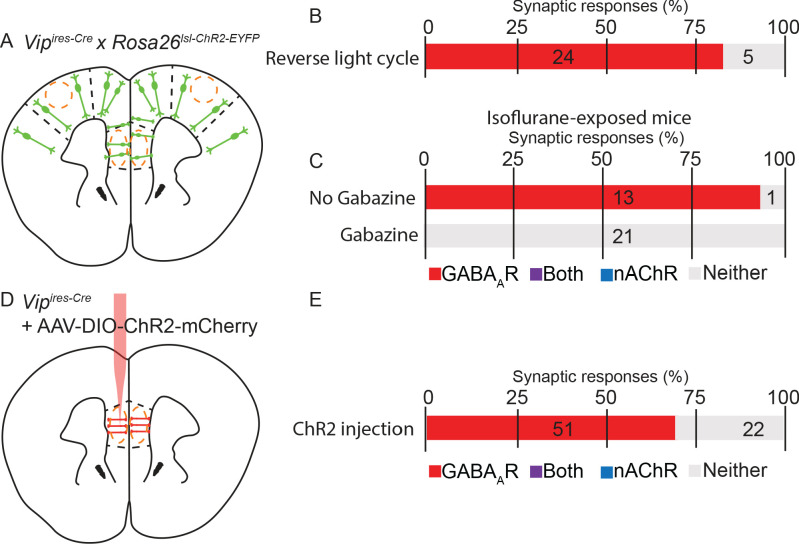
ACh-mediated synaptic connectivity is not effected by circadian cycle or viral injection.(A) Experimental design: Acute slices from Vipires-Cre x Rosa26lsl-ChR2-EYFP mice were prepared and whole cell voltage clamp recordings obtained from layer 1 interneurons. (B) Summary quantification of cells showing post-synaptic responses in mice raised in a reverse-light cycle (n = 29 neurons from 2 Vipires-Cre x Rosa26lsl-ChR2-EYFP mice). (C) Same as (B), but for mice that experience 3 hr of isoflurane exposure 3 weeks before the experiment. In a portion of the experiments, all recordings were obtained in the presence of gabazine to block GABAAR-mediated synaptic responses and allow for more efficient screening for nAChR-mediated responses. (n = 35 neurons from 2 Vipires-Cre x Rosa26lsl-ChR2-EYFP mice). (D,E) Same as (A–C), but for Vipires-Cre mice injected into the mPFC with AAV(8)-DIO-ChR2-mCherry. (n = 73 neurons from 3 Vipires-Cre mice).